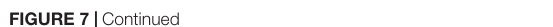
FIGURE 7 | Continued Periostracal material (yellow arrow) and folian-positive material (white arrow) are evident. Scale bar 120 µ m. (C) Additional magnification shows intensely folian-positive cells (pink arrows), possibly hemocytes, which appear to be moving through the epithelium. Secretory cells containing folian-positive granules are visible (orange arrows), one of which appears to be actively secreting product (orange arrow 1). Periostracal material (yellow arrow) is distinct from folian-positive material and appears to float above the folian sheet (white arrow). Scale bar 70 µ